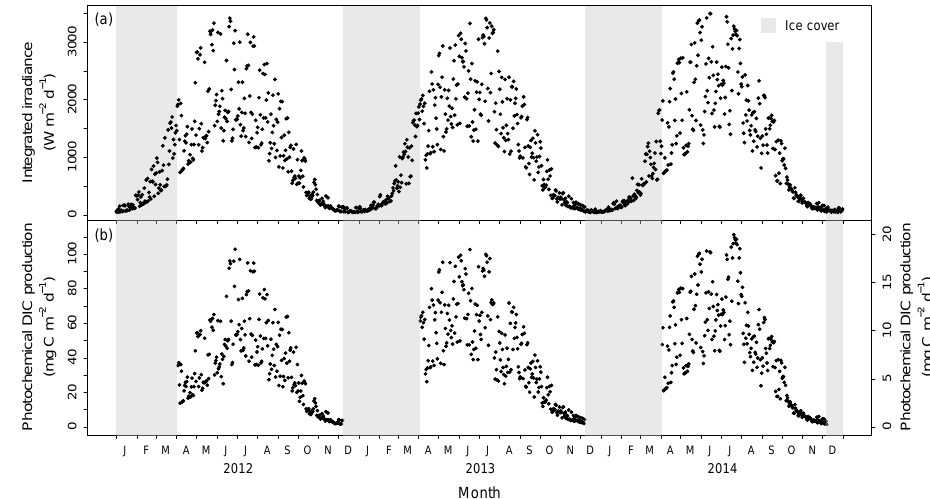
Figure 4. (a) Daily irradiance integrated over the wavelength range 280–600nm. (b) Daily photochemical DIC production rate from 2012 to 2014 using the AQY spectrum with highest (November; primary y axis) and the lowest productivity (July; secondary y axis) measured in 2014. The grey shaded areas mark the ice-covered periods of the lake, during which we set DIC photoproduction to zero assuming no irradiance transmission (Petrov et al.,